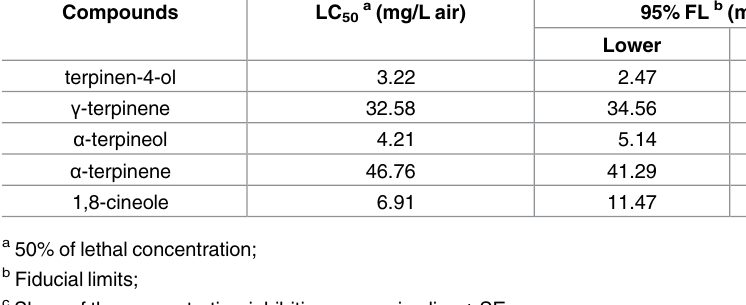
Table 2. Fumigant toxicity of the major constituents of M . alternifolia essential oil against S . zeamais adults.